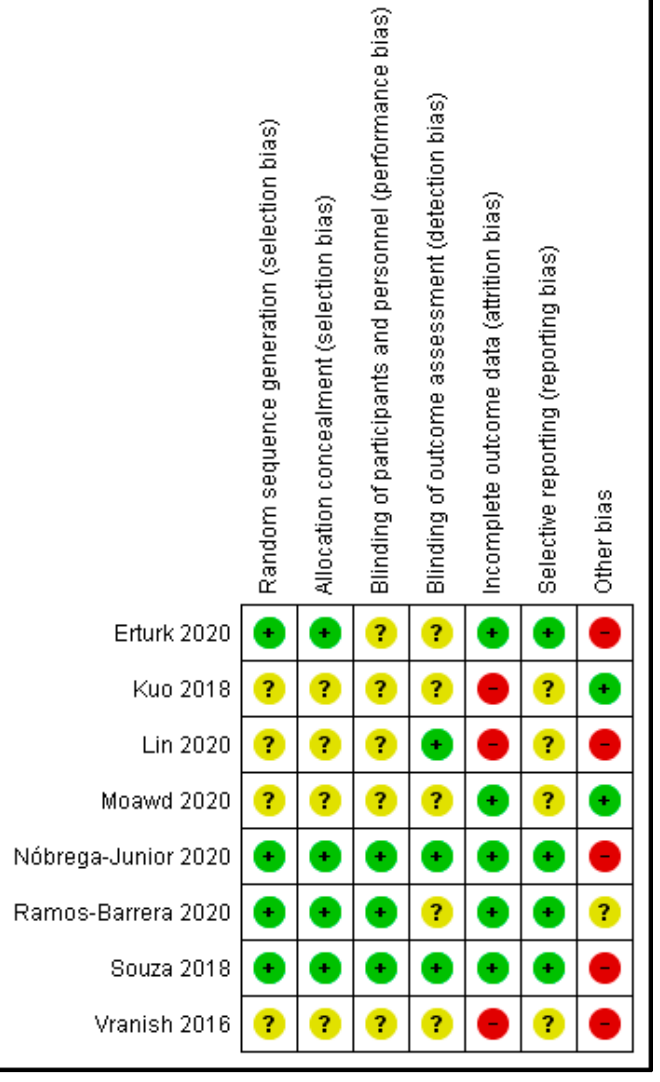
Figure 3. Risk of bias summary.